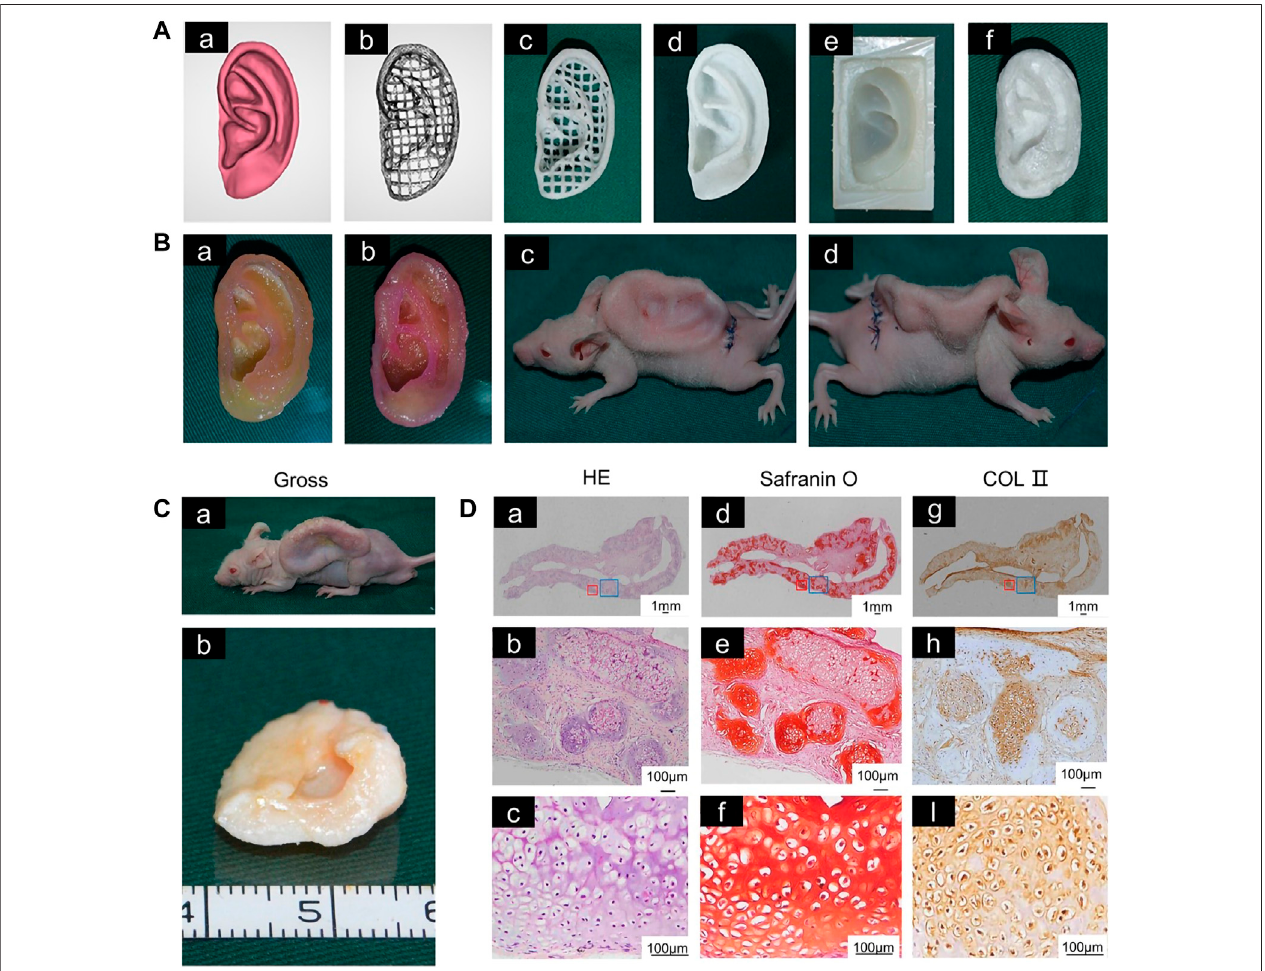
FIGURE1| 3D-printedauricularscaffoldand invivo experiments. (A) Designofa3D-printedauriclemodelandtheresultingprintedscaffold; (a) 3Ddigitalmodelof the human auricle, (b) 3D mesh digital model, (c) PCL inner core, (d) human auricle-shaped PCL positive mold, (e) silicone casting mold, and (f) ACM/Gelatin-PCL scaffold. (B) Auricular scaffold before implantation and after implanting it into a nude mouse for 2 weeks. (C) Images of scaffolds cultured in vivo for 12 weeks. (D) H&E and safranin-O staining showed lacunar structure and cartilage-speci fi c ECM deposition (Jia et al., 2020).